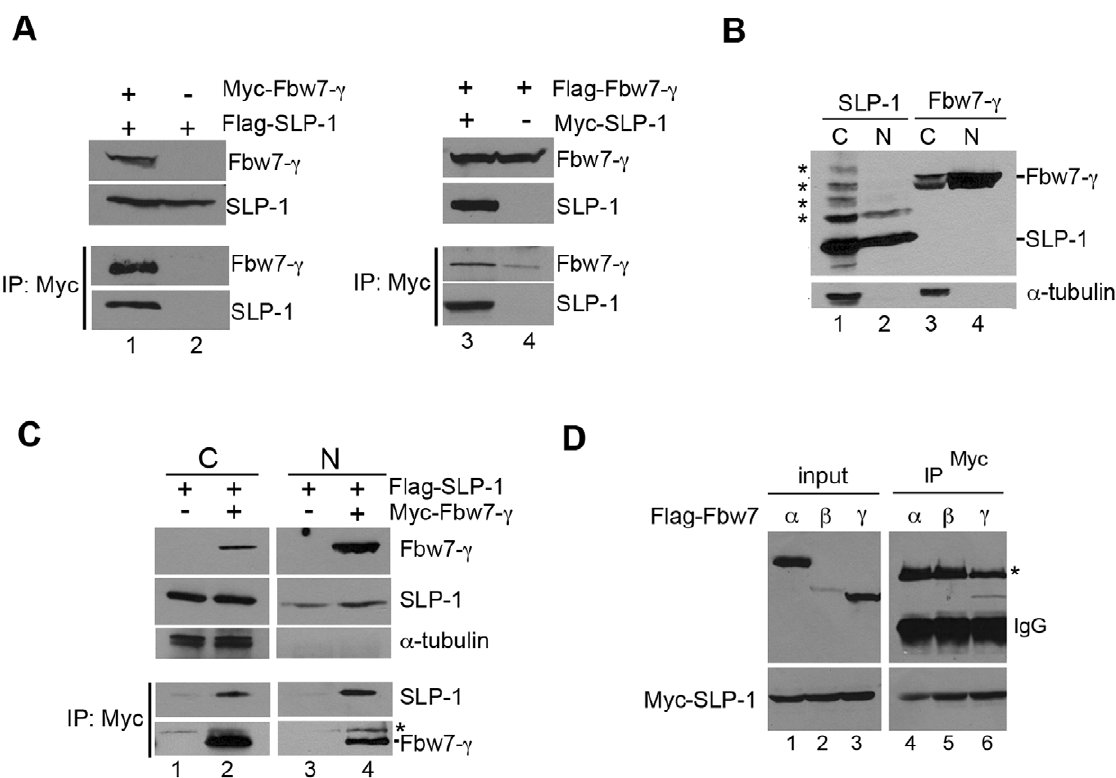
Figure 2. SLP1 is an Fbw7- c -specific interacting protein. A) Fbw7- c co-immunoprecipitates (co-IP) with SLP-1. Flag tagged SLP-1 was co- expressed with Myc-tagged Fbw7- c (lane1) or vector (lane2) in HEK293T cells. Immunoprecipitation was performed as described in Materials and Methods. Reciprocal co-IP is shown in the right panel (lanes 3, 4). B) SLP-1 and Fbw7- c co-fractionate. Standard fractionation assays from cells co- expressing Flag-tagged SLP-1 and Flag-tagged Fbw7- c were performed as described in Materials and Methods. a -tubulin, a cytosolic protein, was used as a control. Asterisks indicate modified forms of SLP-1, C=cytosolic, N=nuclear. C) SLP-1 and Fbw7- c co-immunoprecipitate in both nuclear and cytosolic fractions. Co-IPs were performed as in (A), except that cellular fractions from (B) were used. Asterisks indicate non-specific cross-reacting band. D) The Fbw7- c and SLP-1 interaction is specific. Flag-tagged Fbw7 isoforms were co-expressed with myc-tagged SLP1. Immunoprecipitations were performed as in (A). IgG refers to heavy chain of the anti-Myc antibody, * indicates a non-specific